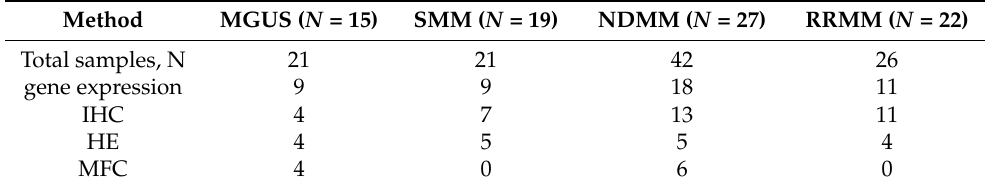
Table 2. Classification of samples included in the study ( N = 110) according to the analysis performed. Method gene